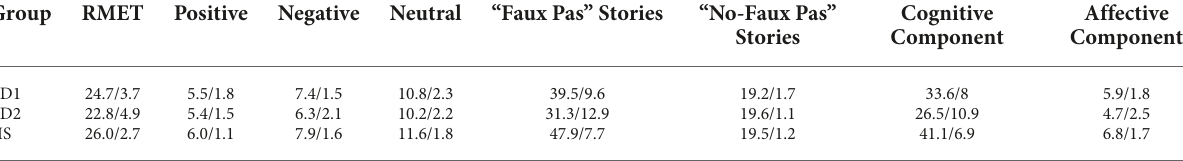
TABLE 3 Mean and Standard deviation of the ToM scores. Group